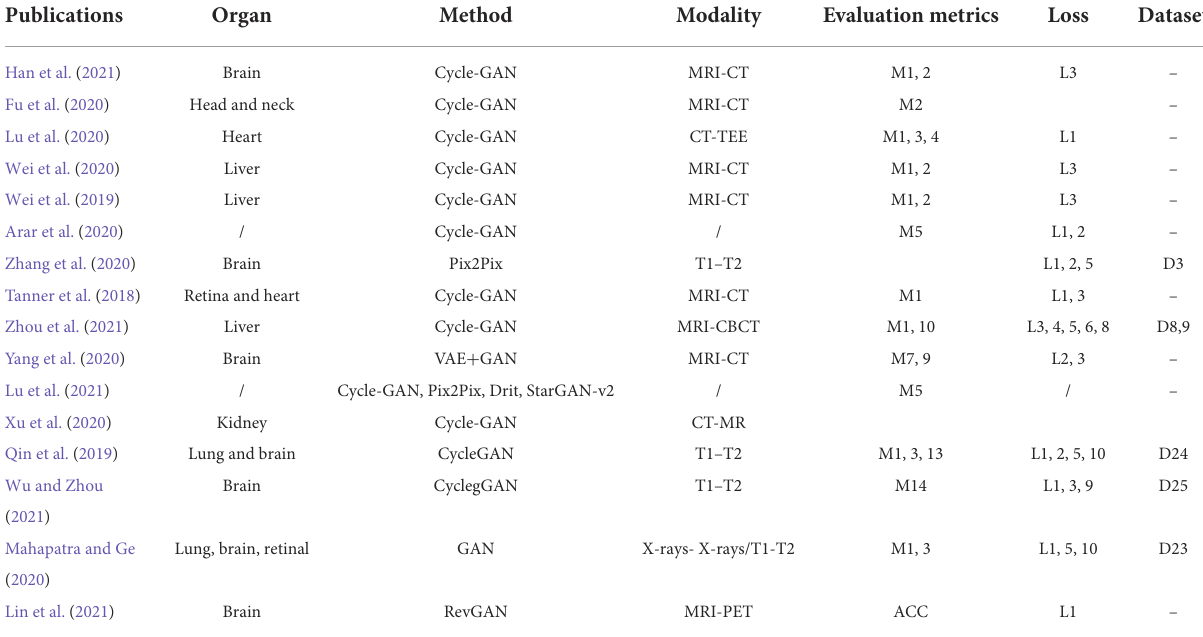
TABLE 2 Overview of the modality-independent based